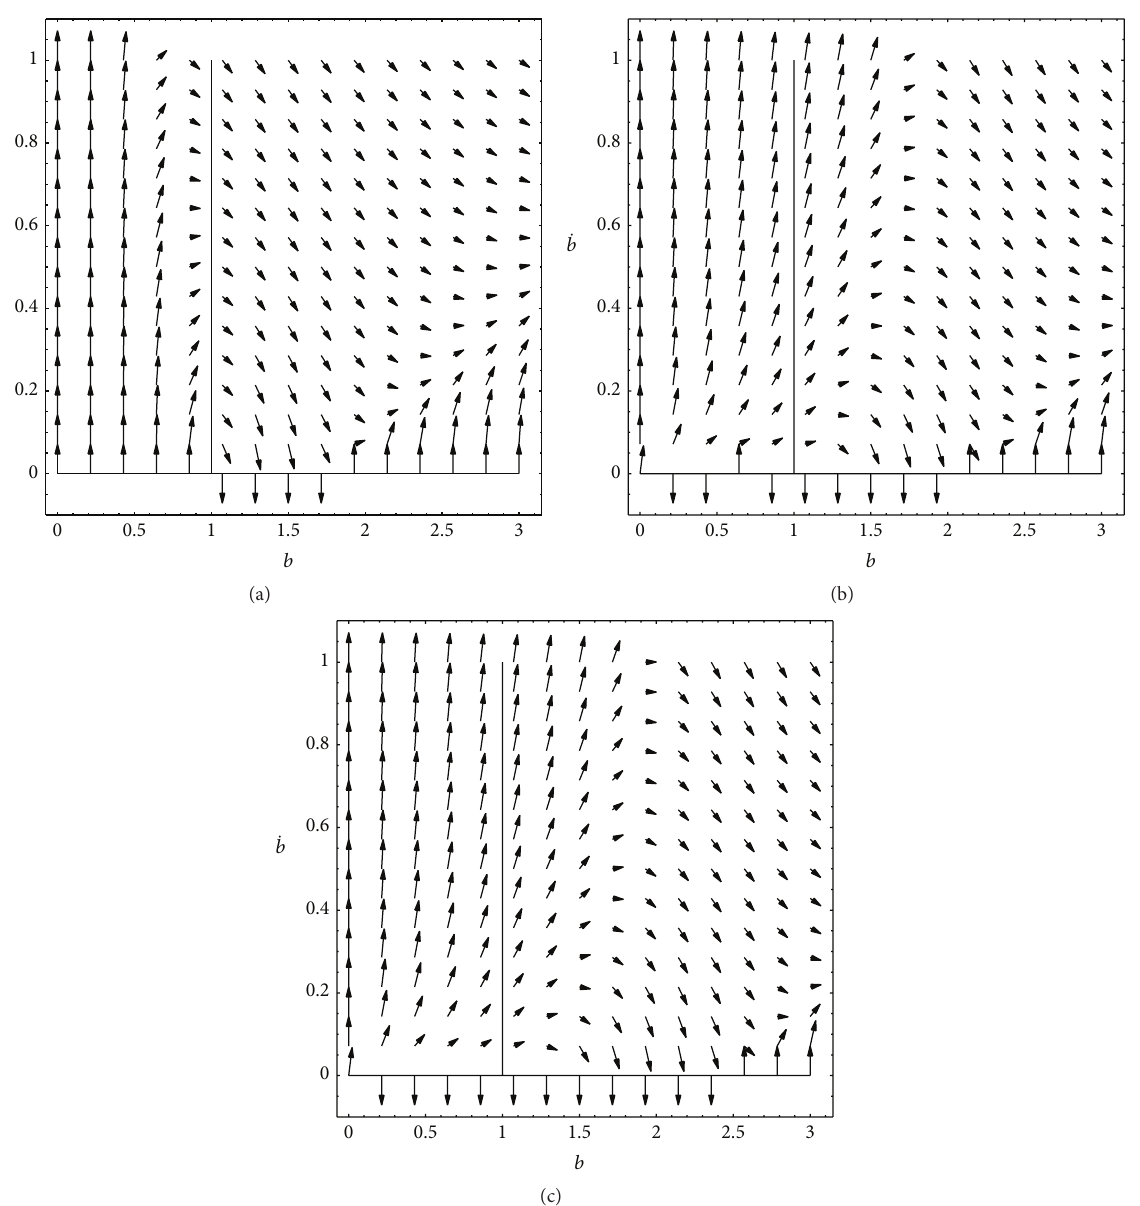
Figure 1: Phase space for model 2. We consider here a unit such that Λ = 1 . We show (a) for 𝛾/𝛼 = 0 , (b) for 𝛾/𝛼 = 1 , and (c) for 𝛾/𝛼 = 2 ,